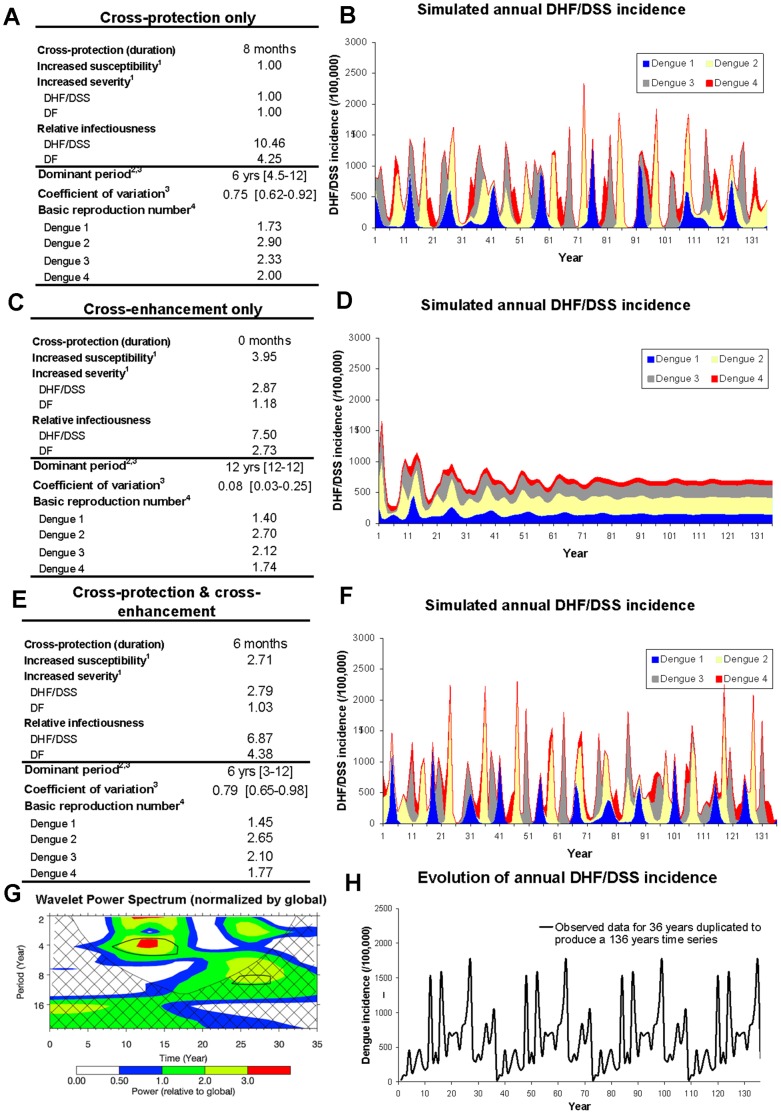
Simulated and observed evolution of annual dengue incidence for different scenarios of serotype interactions: Model simulation with short term cross-protection only (A,B), Model simulation with cross-enhancement only (C,D), Model simulation with cross-protection & cross-enhancement (E,F).Wavelet analysis for observed data (G) and observed annual DHF/DSS incidence corrected for under-reporting (H). Footnotes of panels A, C, E: 1. Increased susceptibility and severity in case of secondary infection 2. Dominant period assessed using Fourier power spectrum over 36 consecutive years, 3. Median, minimum and maximum 4. The basic reproduction number reported is the annual average (average vector density and daily biting rates). In Wavelet analysis for observed data (G), the power has been scaled by the global wavelet spectrum. The cross-hatched region is the cone of influence, where zero padding has reduced the variance. Black contour is the 10% significance level [41]. The 36 years of available data were duplicated to improve comparability with model results (H).